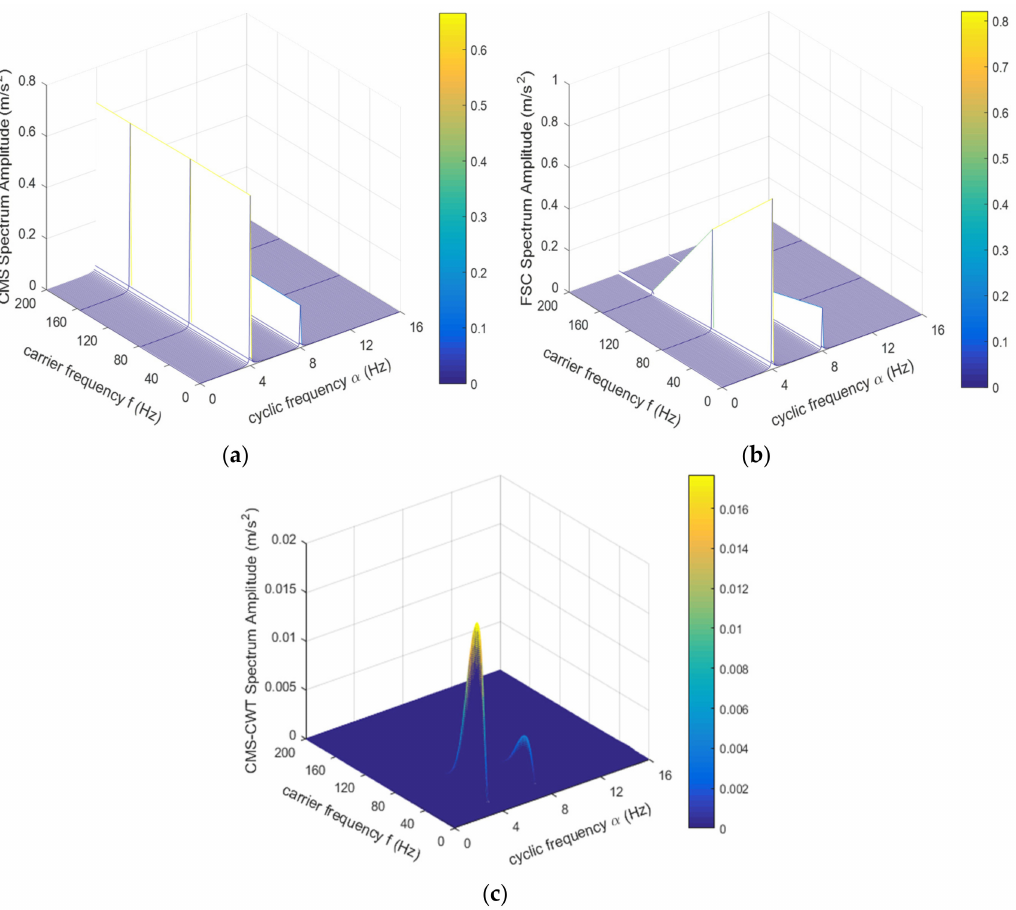
Figure 7. Three-dimensional vibration spectrum analysed by ( a ) CMS, ( b ) FSC, and ( c ) CMS-CWT with Fs = 10,000